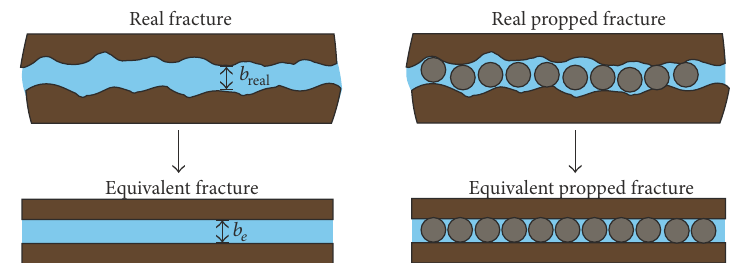
Figure 5: Simplified fracture models with parallel plate flow and porous medium flow.